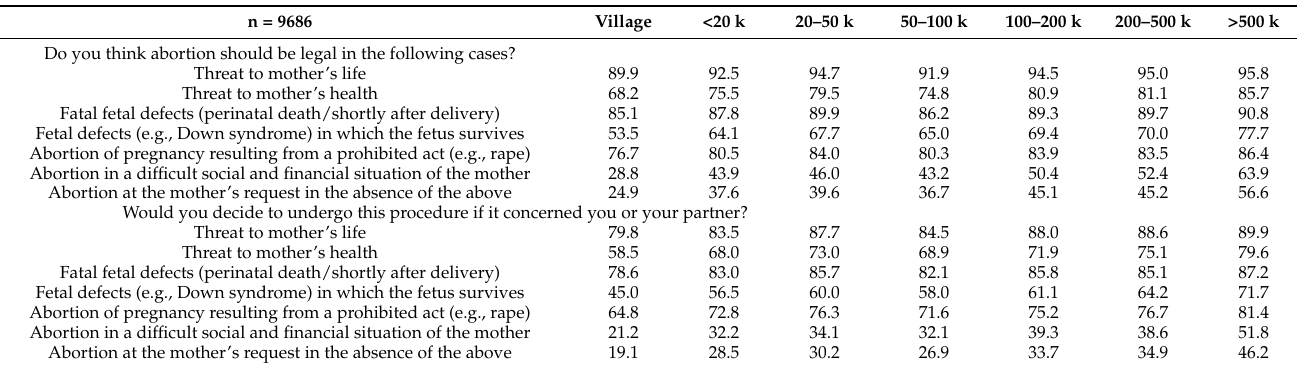
Table 6. Attitude to abortion regarding place of residence. All data contained in table are presented as percentage [%] of answers YES in each case.